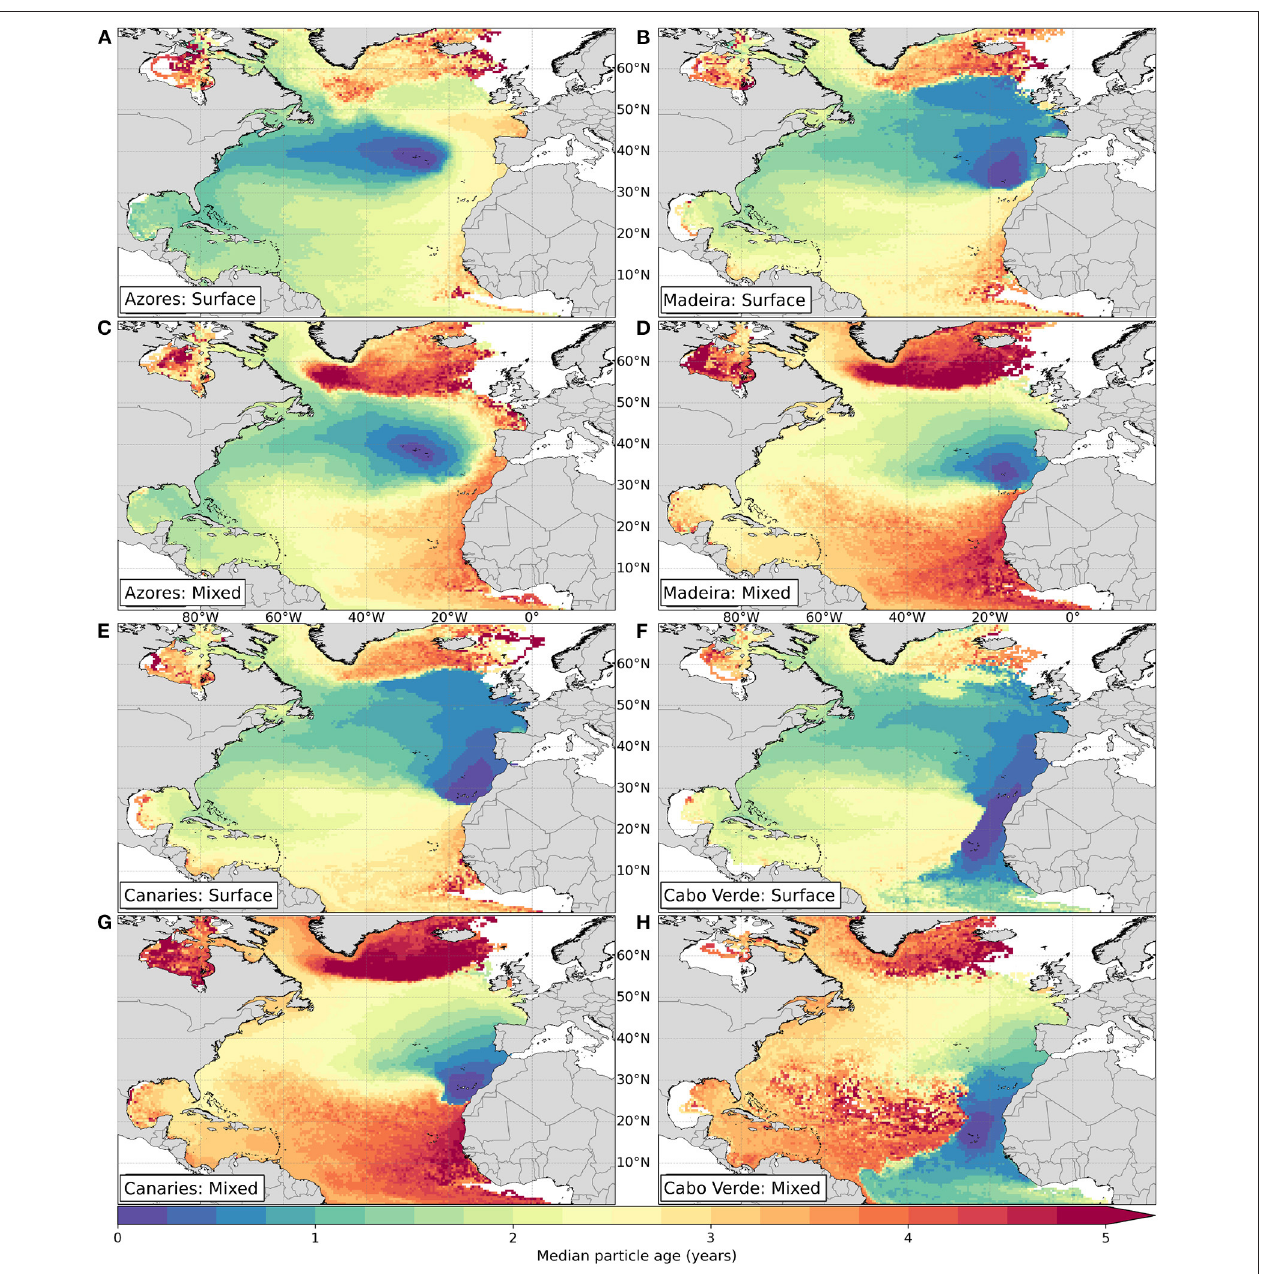
FIGURE 5 | Median age of B surface (A,B,E,F) and B mixed (C,D,G,H) particles before intercepting the archipelagos, detected in 0.5 ◦ grid cells. Color scale is divided with a 3-month